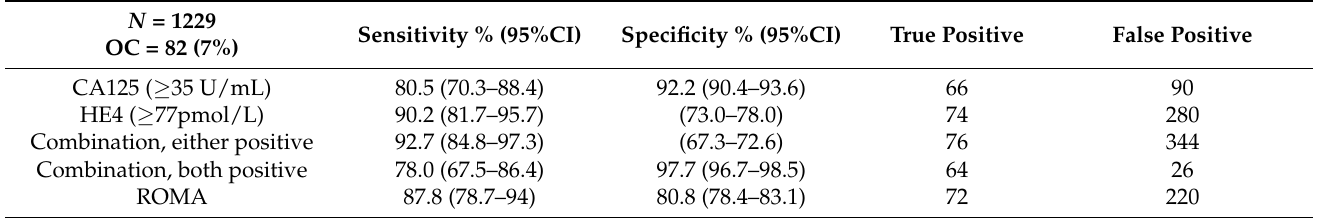
Table 3. Overall sensitivity and specificity of serum HE4, CA125 (alone and in combination) and ROMA for the detection of ovarian cancer.